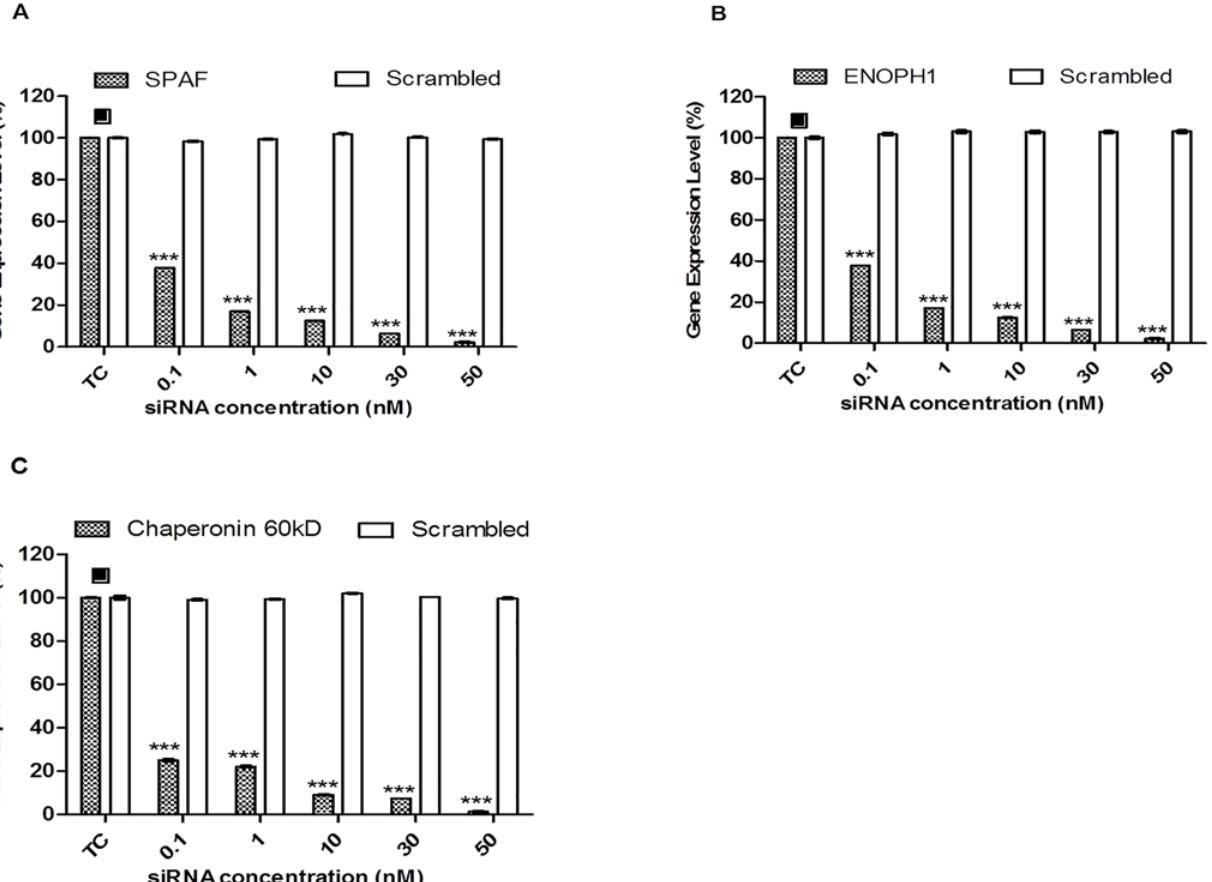
Fig 5. RNA levels on selected cellular genes. Scrambled siRNA-transfected cells (represented by white bars) against (A) Spermatogenesis-associated factor, (B) Enolase phosphatase e-1 and (C) Chaperonin-60kD show no knockdown of gene expression when compared to transfection control (TC). Cells transfected with targeted cellular siRNAs (represented by shaded bars) against (A) Spermatogenesis-associated factor, (B) Enolase phosphatase e-1 and (C) Chaperonin-60kD showed significant knockdown across all genes tested compared to transfection control (TC). The asterisk indicates * p values < 0.05, ** p values of < 0.01 and *** p values < 0.0001 by Student ’ s t test. Asterisks indicate statistically significant results relative to control group ( ■ ).